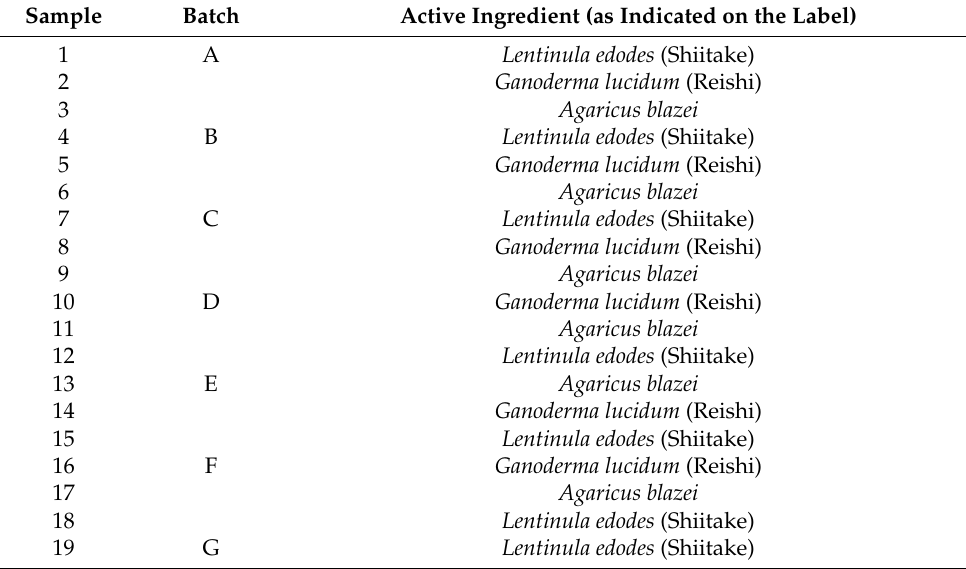
Table 1. List of mushroom-based supplements commercial products analyzed in the survey. Sample Batch Active Ingredient (as Indicated on the